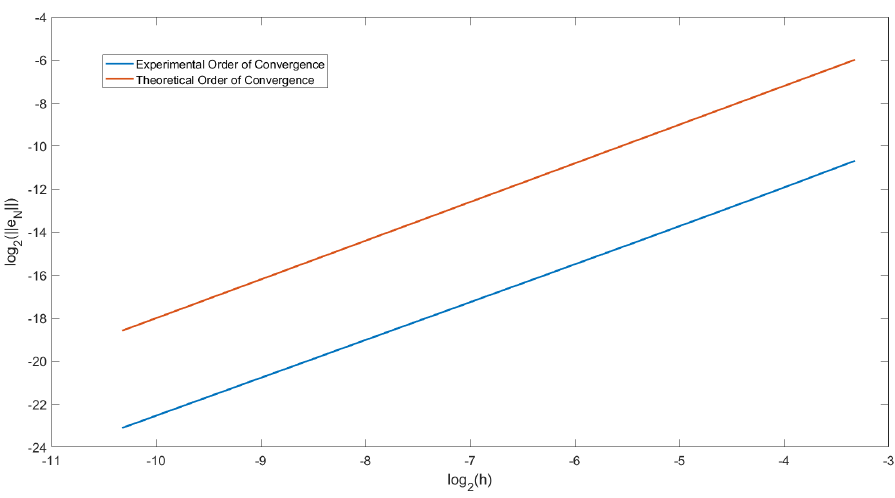
Figure 3. Graph showing the experimental order of convergence (EOC) at T = 2 in Example 3 with α = 0.8 and r = 1 + α 2 α